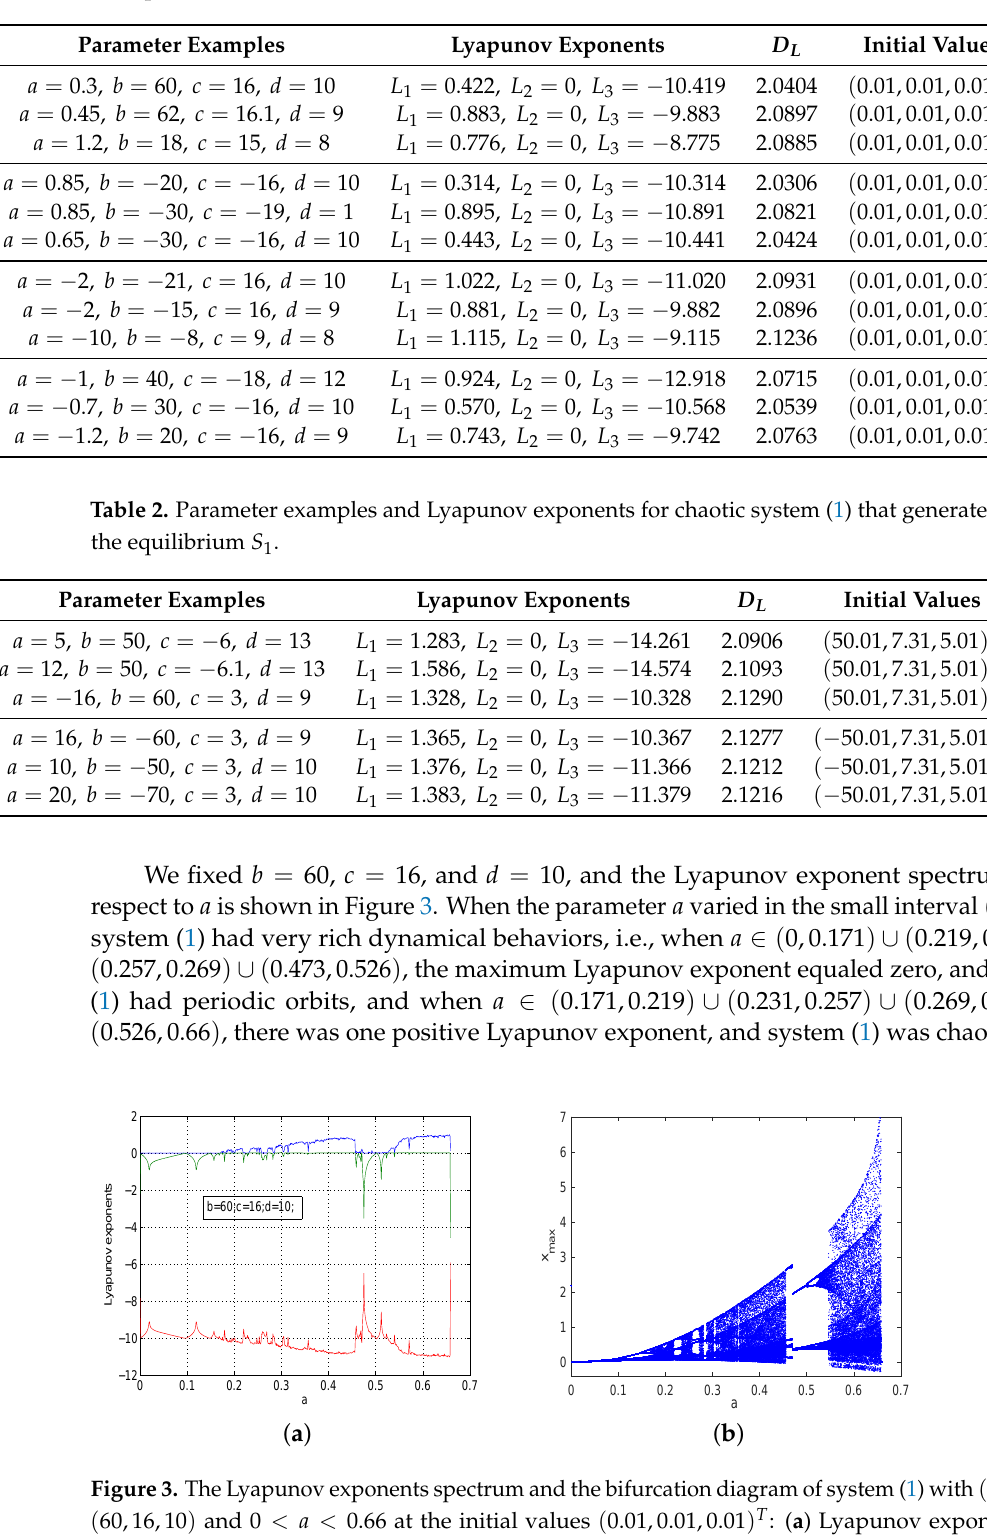
Table 1. Parameter examples and Lyapunov exponents for chaotic system (1) that generate chaos at the equilibrium S 1 .